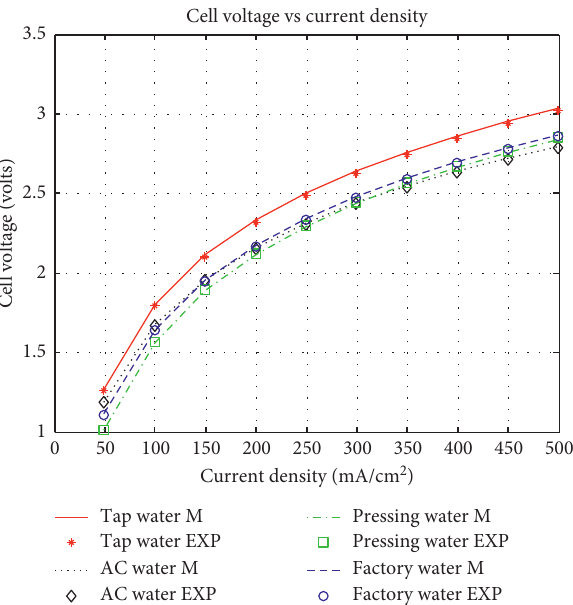
Figure 5: I-V curve for different types of electrolyte.